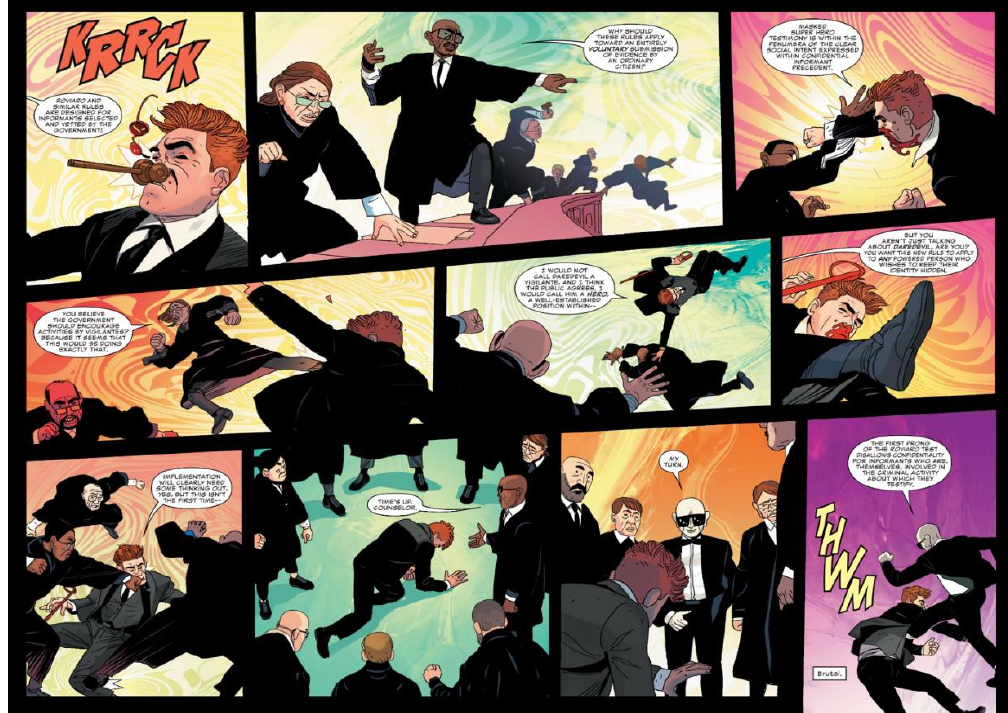
Figure 13. Page from Soule’s Daredevil: Back in Black Vol. 5: Supreme #25, 2017. Image Credit (Figures 12, 13): Alec Morgan © 2017 Marvel Characters,